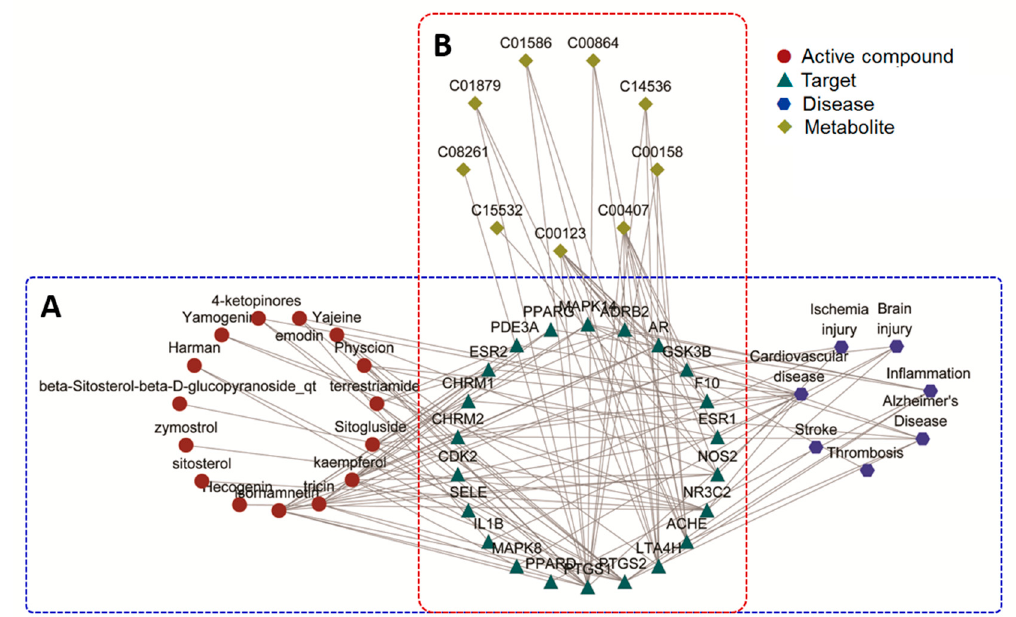
Figure 5. The “compound-target-disease” network ( A ) and “target-metabolite” network ( B ) based on 15 compounds, 22 targets, 7 diseases, and 9 metabolites. Table 1. Annotated endogenous metabolites and their change trends in urine.